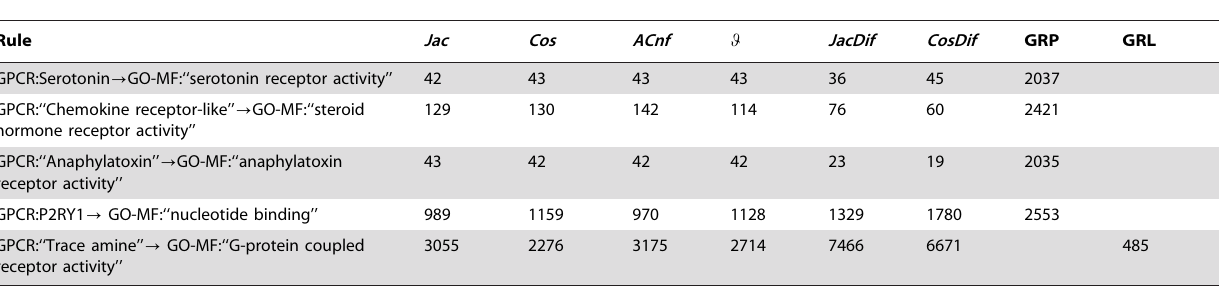
Table 9. Rule Rankings for GPCR-GO-MF dataset.